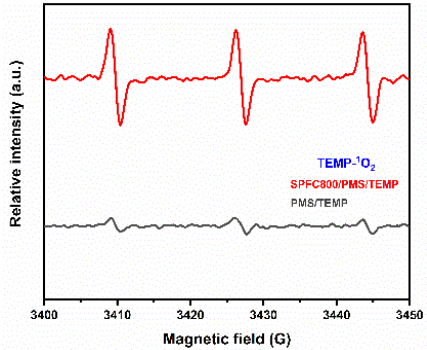
Figure 5. Electron paramagnetic resonance (EPR) spectra of PMS activation by SPFC800: TEMP- 1 O 2.